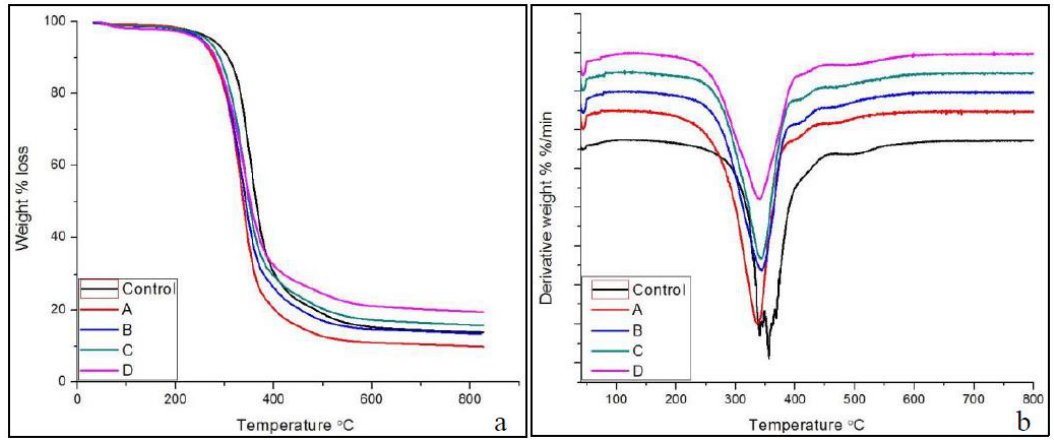
Figure 4. Figure 4. ( a ) TGA and ( b ) DTG of PUF control and CNF-PUF with 10–40% CNF replacement